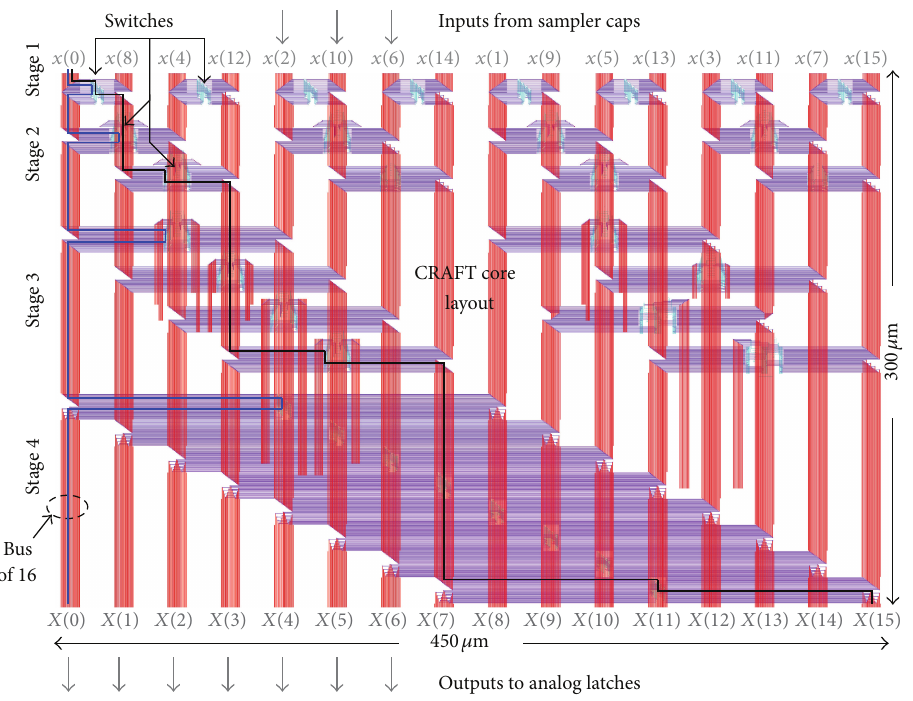
Figure15:LayoutoftheCRAFTprocessingcorewithtwohighlightedexamplesamplingcapacitordistributioncasestobenominallymatched for parasitics.